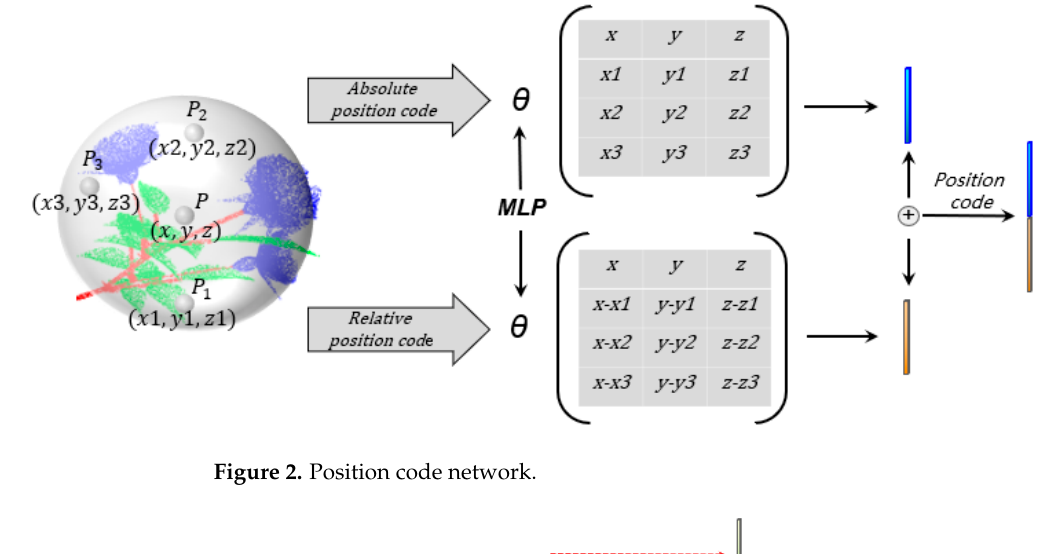
Figure 2. Position code network.